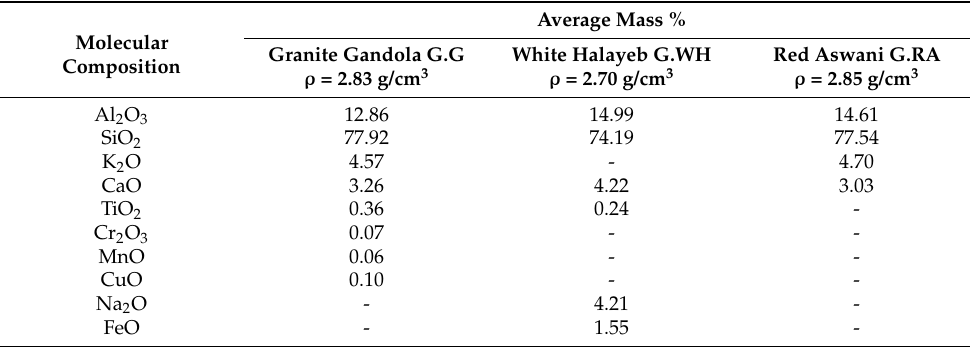
Table 1. The average chemical composition of the investigated granites.